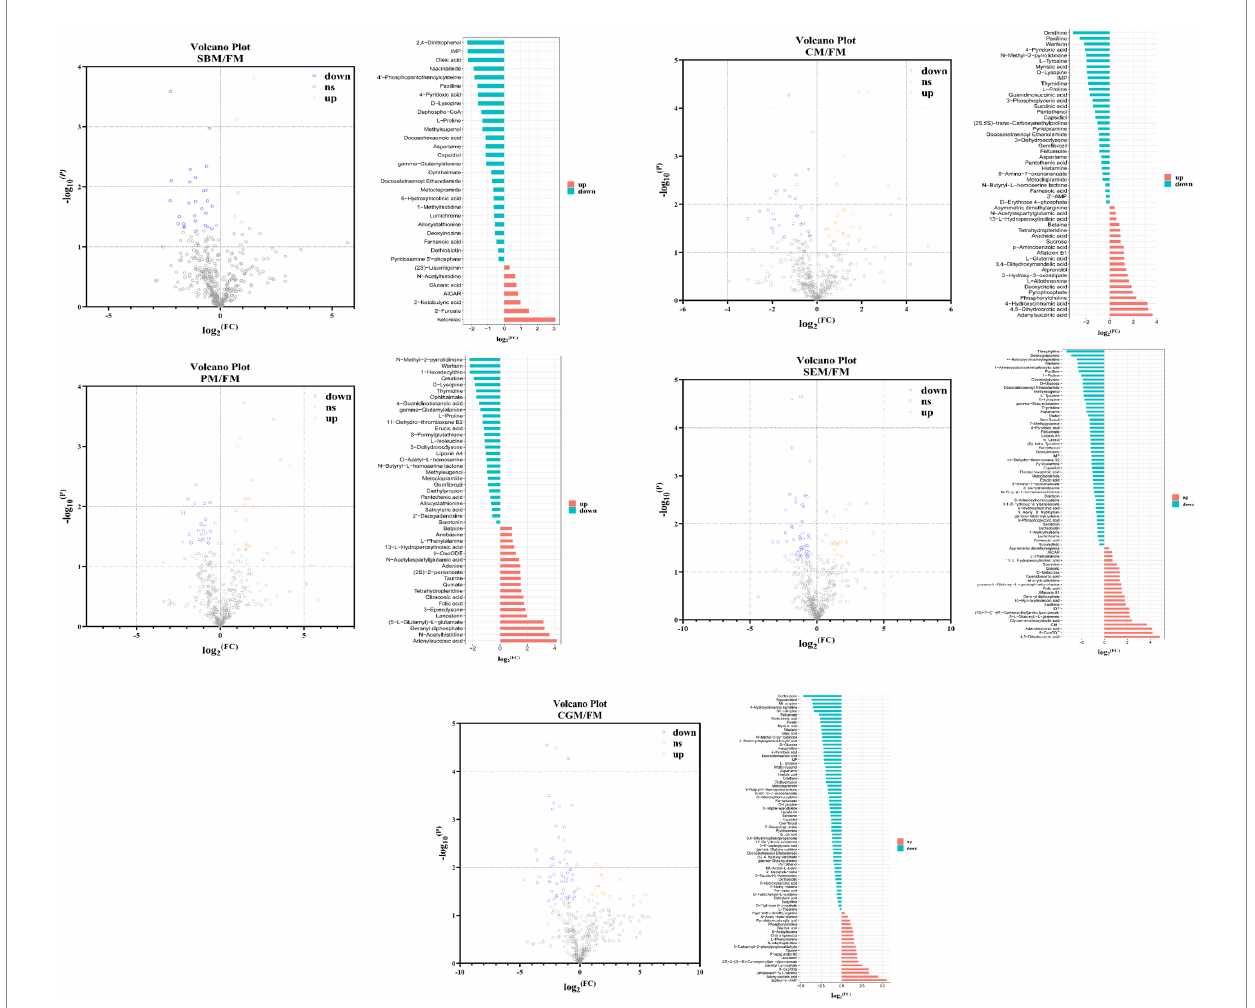
FIGURE 4 In the volcano diagram on the left, the blue circle represents the significantly down-regulated metabolites, the orange circle represents the significantly up-regulated metabolites, and the gray circle represents the metabolites that had no significant difference compared to the FM group. The bar chart on the right shows the names and fold changes of differential metabolites. The left extension represents the down-regulated metabolites, and the right extension represents the up-regulated